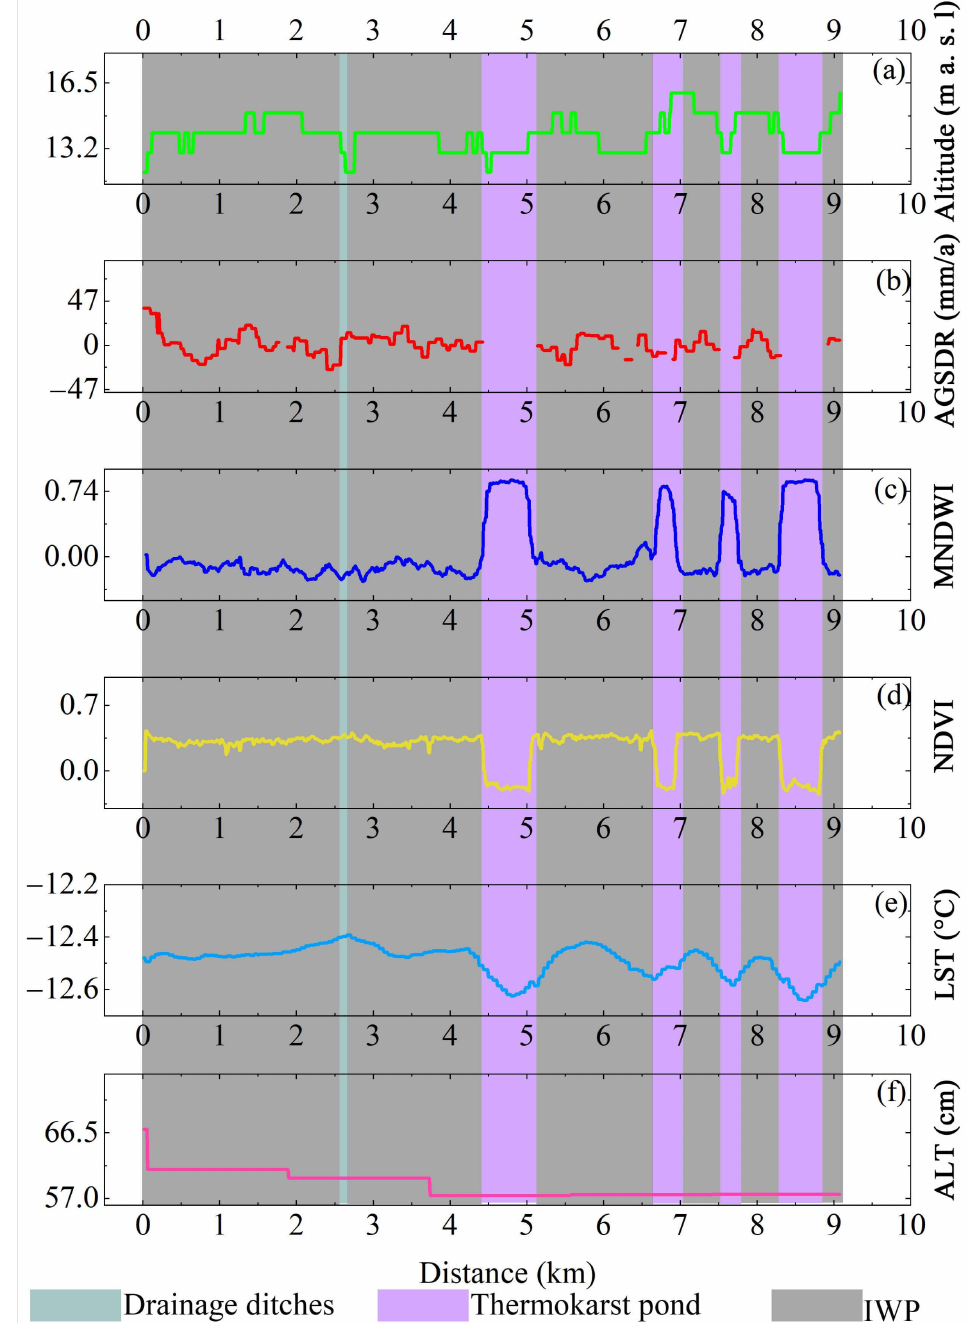
Figure 8. The N–S transect at Saskylakh, Anabarsky District, the Sakha Republic, Russia (The starting point of the N–S Transect is 0.0 km from the NS Transect in Figure 2); We canceled the bold font. Notes: ( a ) is the altitude (m a. s. l); ( b ) is the annual ground surface deformation rate (AGSDR, mm/a); ( c ) is the modified normalized difference water index (MNDWI, − 1~1). For thermokarst pond: MNDWI > 0; ( d ) is the normalized difference vegetation index (NDVI, − 1~1); ( e ) is the land surface temperature (LST, ◦ C); and ( f ) is the active layer thickness (ALT,